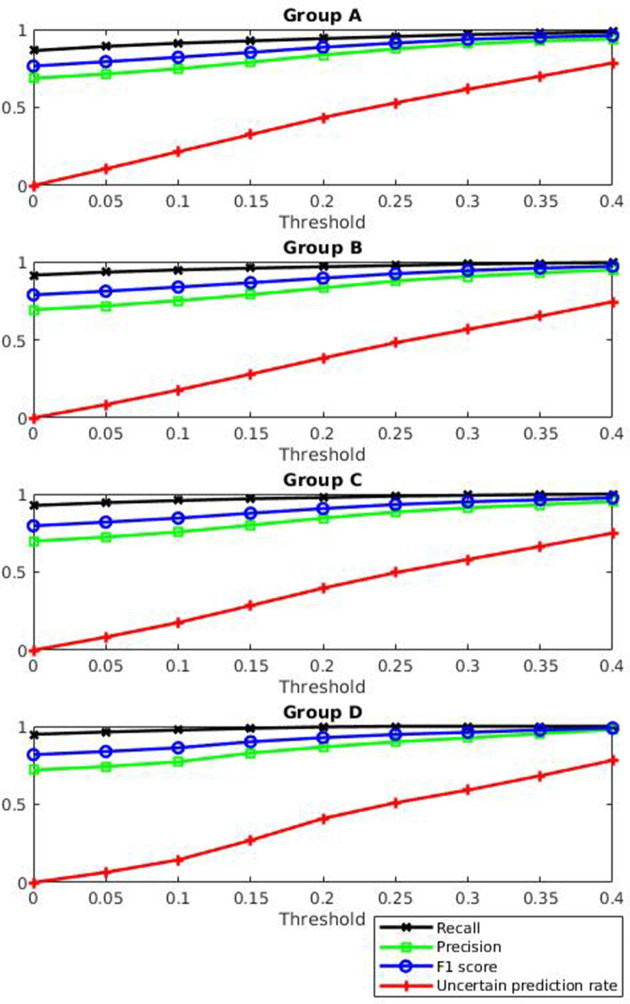
PlasTrans performance with different thresholds. Under a given threshold, t, a sequence with a score falling into the interval of |score−0.5|<t will be labelled as uncertain. Uncertain prediction rate, recall, precision and F1 score values of PlasTrans with different thresholds are evaluated.